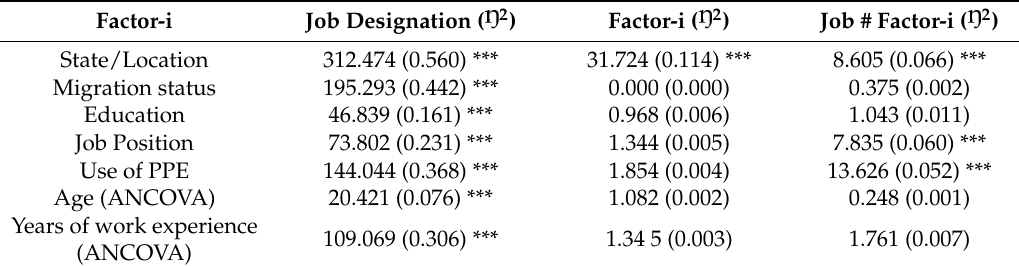
Table 3. F -values of the Two-Way ANOVA for the knowledge score.